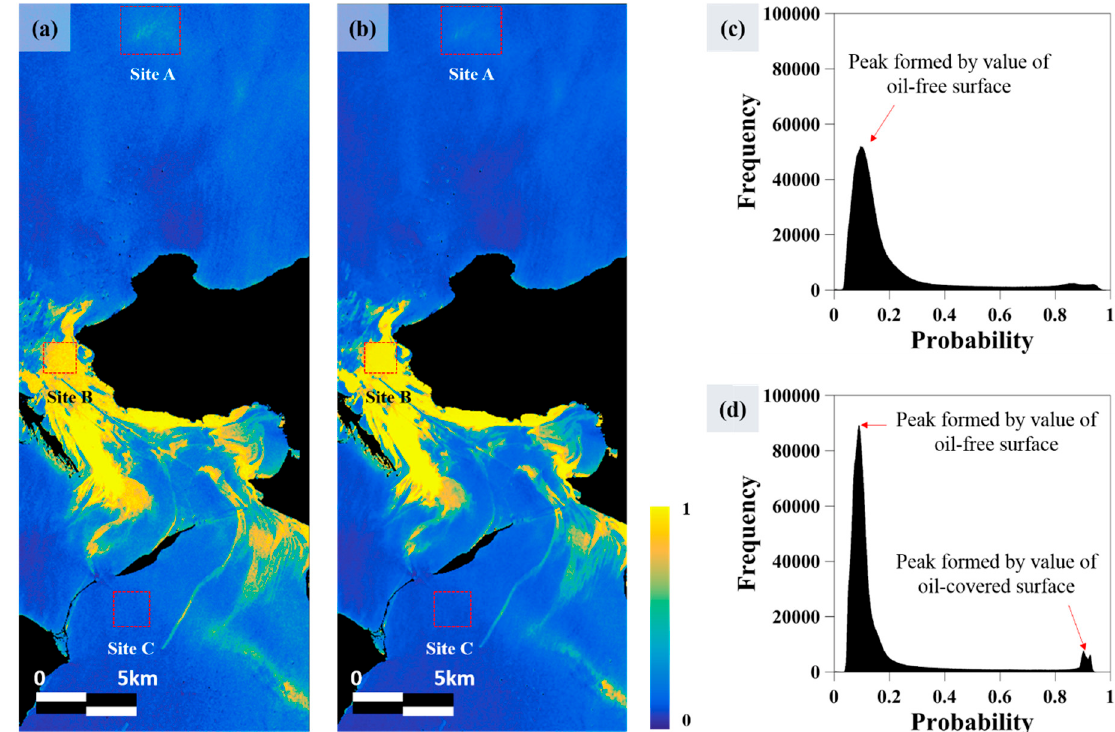
Figure 9. ( a ) Probability map of oil spill estimated following Process 1; ( b ) Probability map of oil spill estimated following Process 2; ( c ) Histogram of probability for the result of Process 1; ( d ) Histogram of probability for the result of Process 2.